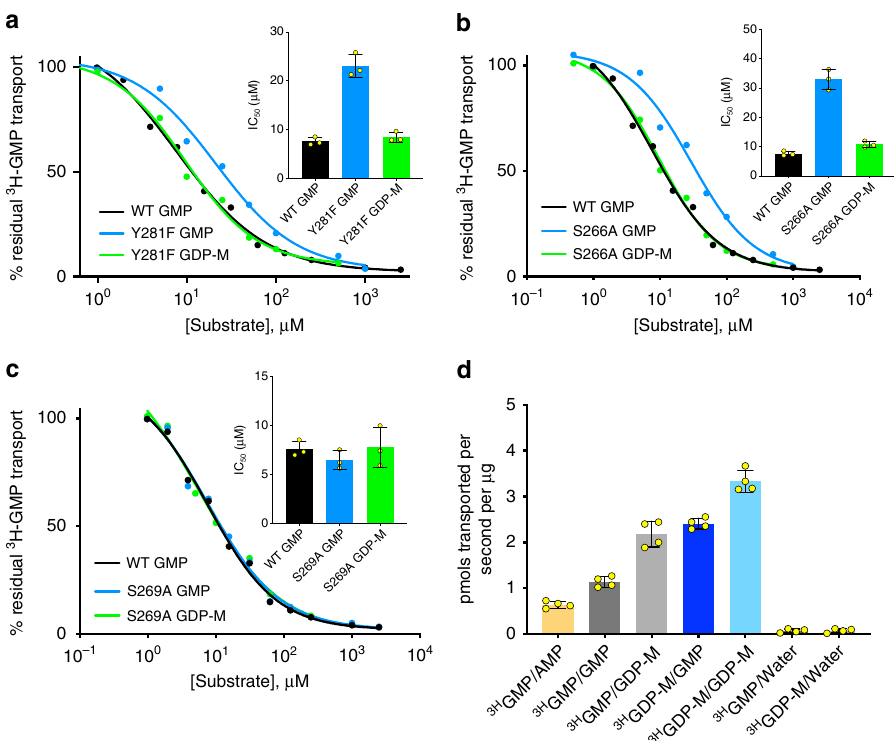
Fig. 2 Characterisation of the GMP binding site. a , b , c Representative IC 50 curves determined for both GMP and GDP-mannose in the Y281F, S266A, and S269A variants, respectively. Insets show the calculated IC 50 value from three independent experiments, errors shown are standard deviations (s.d) of the mean. d Transport assays showing the highest level of transport occurs when GDP-mannose is present on both sides of the liposome membrane. n = 4 independent experiments, error bars s.d. Source data are provided as a Source Data fi